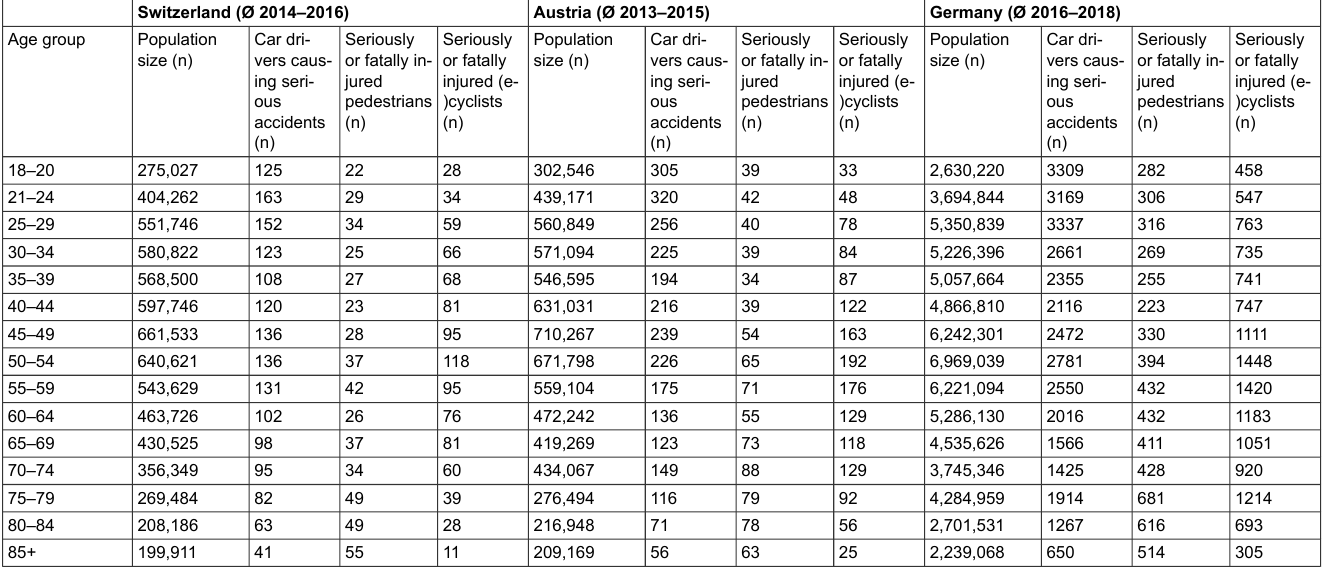
Table 2: Population sizes, numbers of accidents and injuries per age group and country. Switzerland (Ø